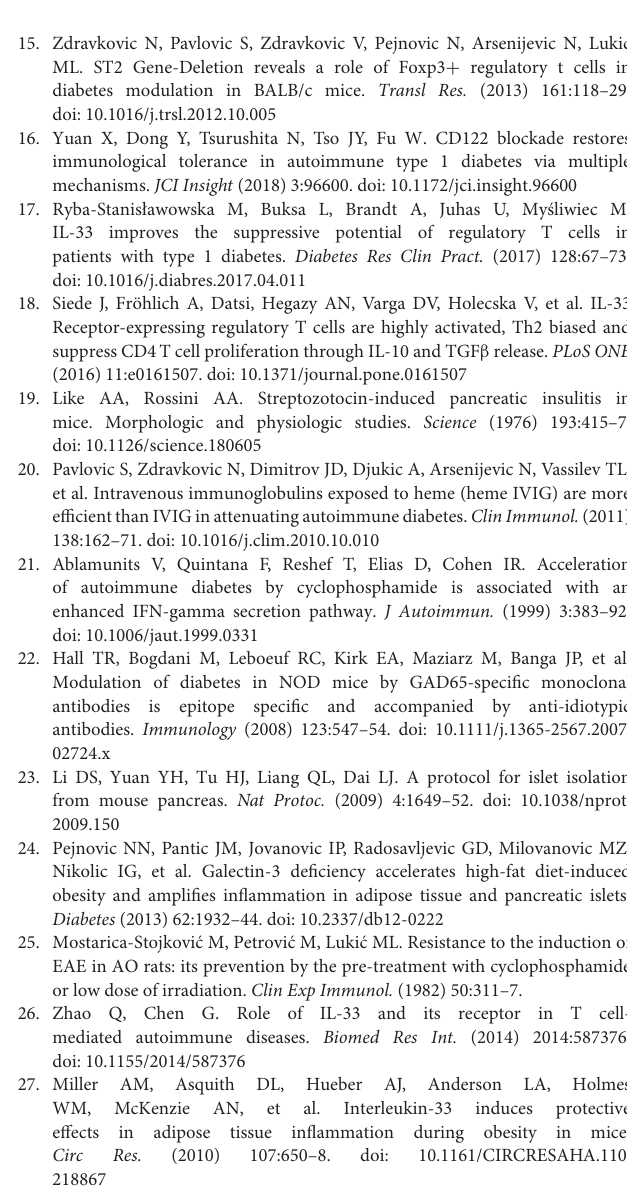
Figure S1 | Gating strategy and representative dot and contour plots for the data presented in Figure 2 and Figure 3. The main findings are indicated in corresponding quadrant. Figure S2 | Gating strategy and representative dot and contour plots for the data presented in Figure 4 . The main findings are indicated in corresponding quadrant. Figure S3 | Representative dot and contour plots for the data presented in Figure 7. The main findings are indicated in corresponding